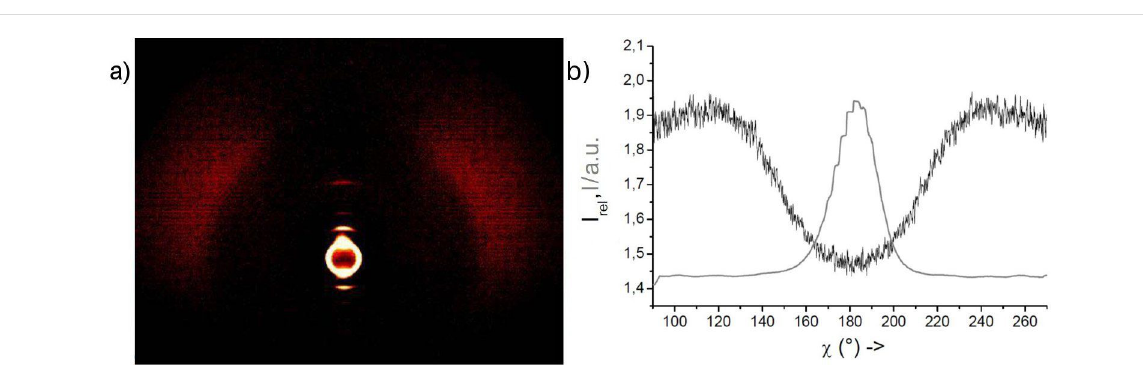
The current response shows two peaks per half period, which is typical for an antiferroelectric switching. The spontaneous po- larization amounts to 500 nC/cm 2 (Figure 16b). Action of an electric D.C. field shows a transition from a striped, fan-shaped texture to a smooth one (Figure 17). The X-ray diffraction measurements on the monotropic liquid- crystalline phase of OH 4d show the patterns of a tilted smectic layer structure with a layer spacing of 4.3 nm and a 30° tilt of